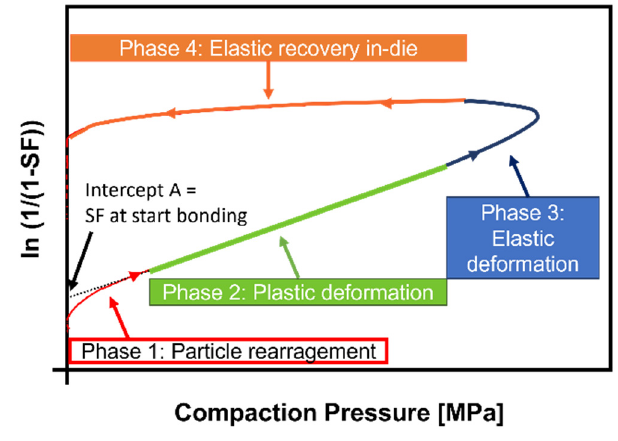
Figure 1. Schematic Heckel plot in-die.